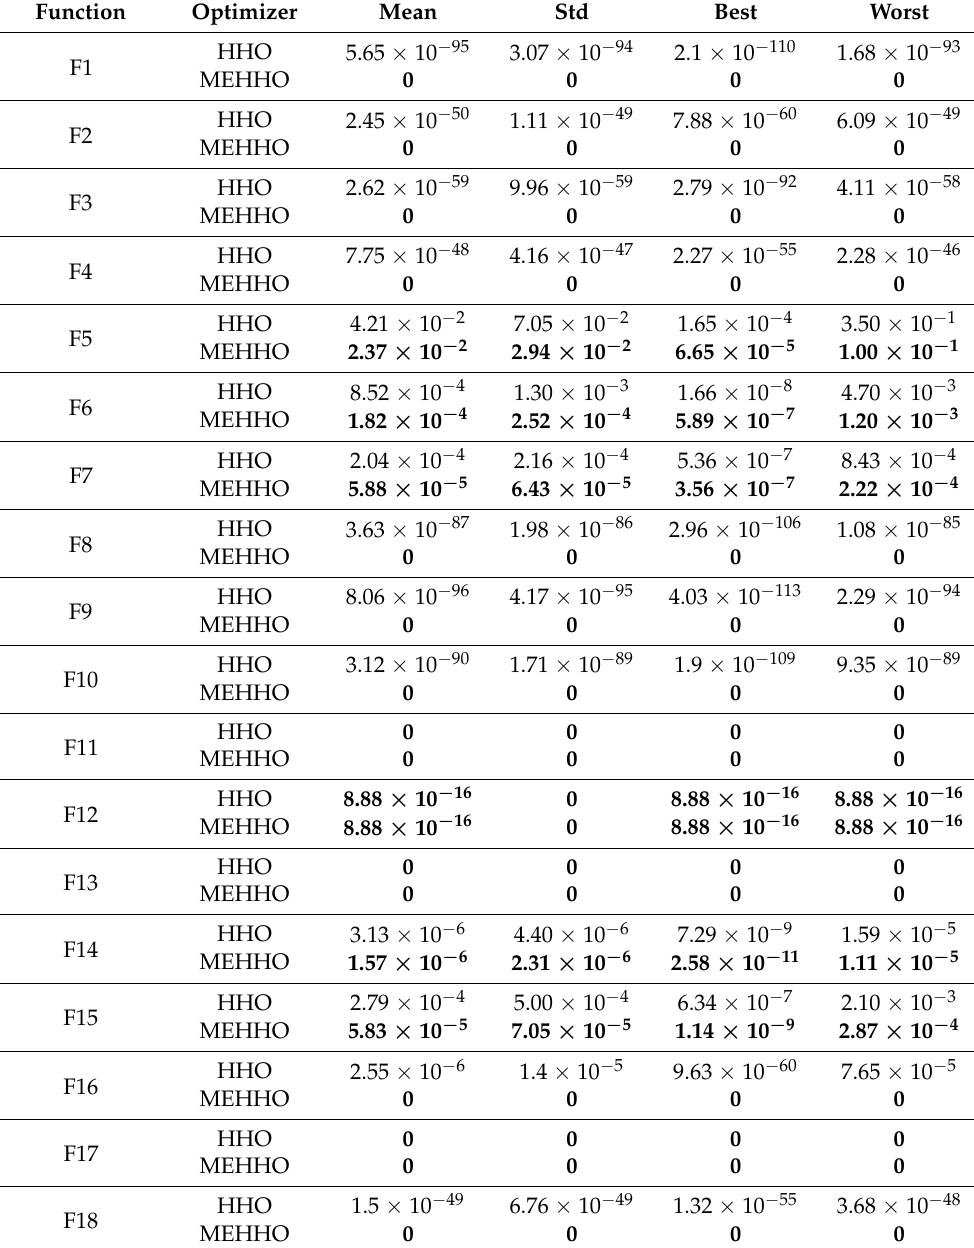
Table 8. Results comparison of variable-dimensional functions (100